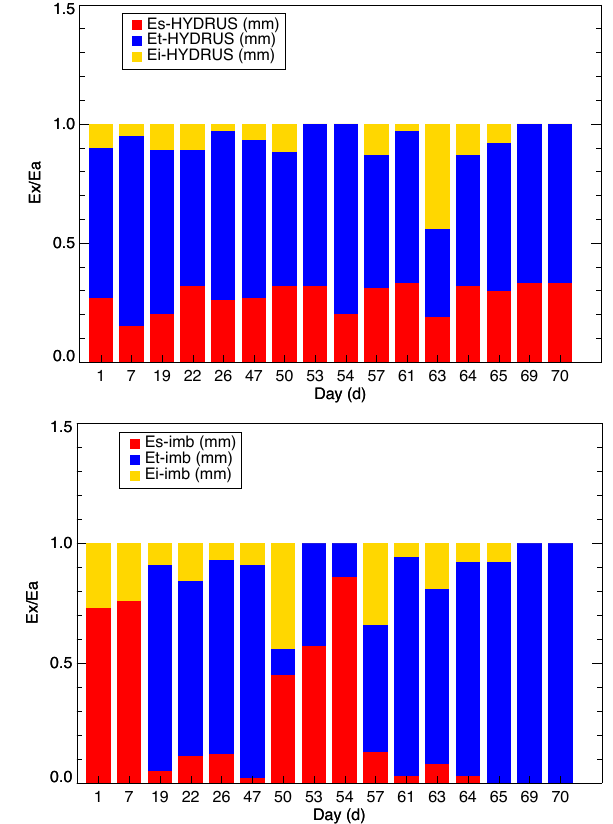
Fig. 8. The ratio of partitioning fluxes compared to total evap- oration ( E x / E a ). x stands for soil evaporation, transpiration and